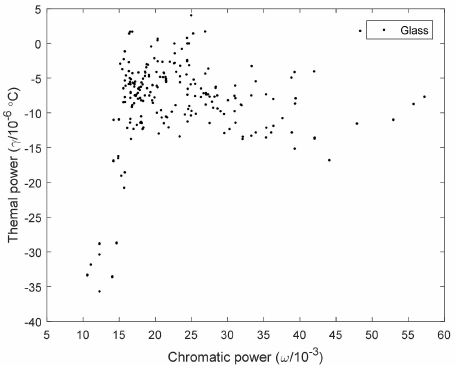
Figure 9. Athermal glass map of the Chengdu Guangming catalog calculated by